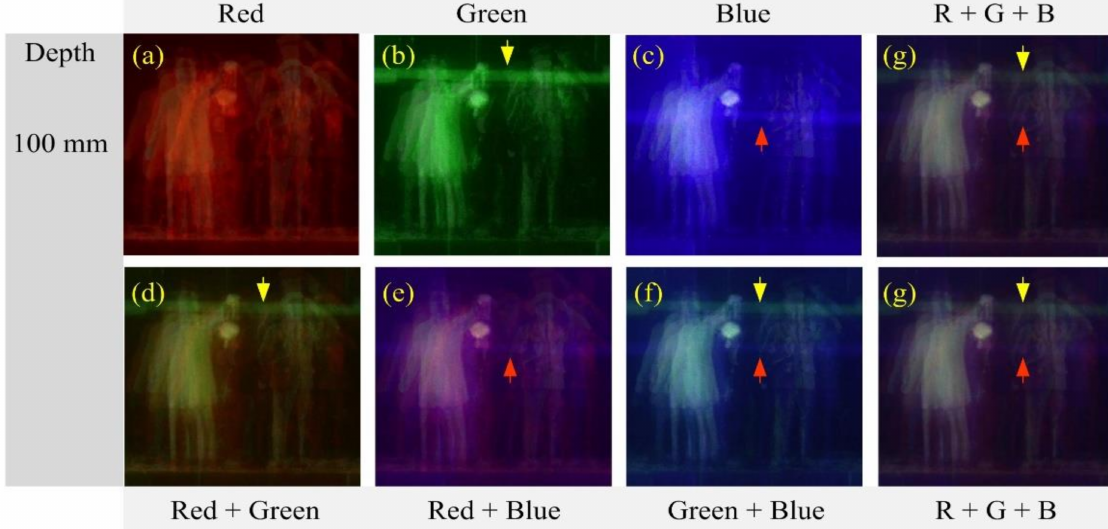
Figure 13. Reconstructed images for the human object at the depth z = 100 mm. ( a ) Red ( b ) Green ( c ) Blue ( d ) Red + Green ( e ) Red + Blue ( f ) Green + Blue, and ( g ) Red + Green + Blue